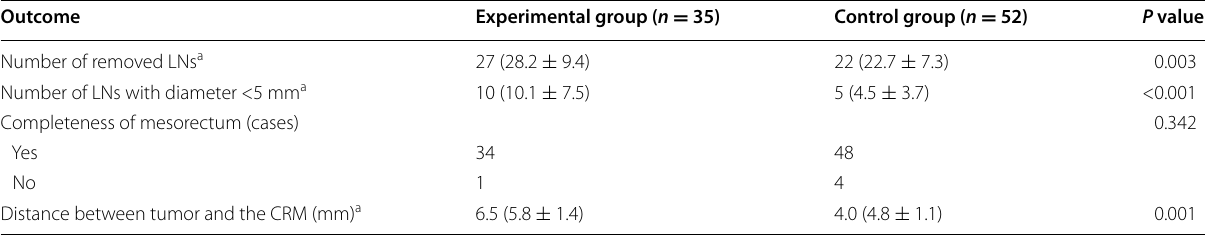
LN lymph node, CRM circumferential resection margin a Values are presented as median (mean